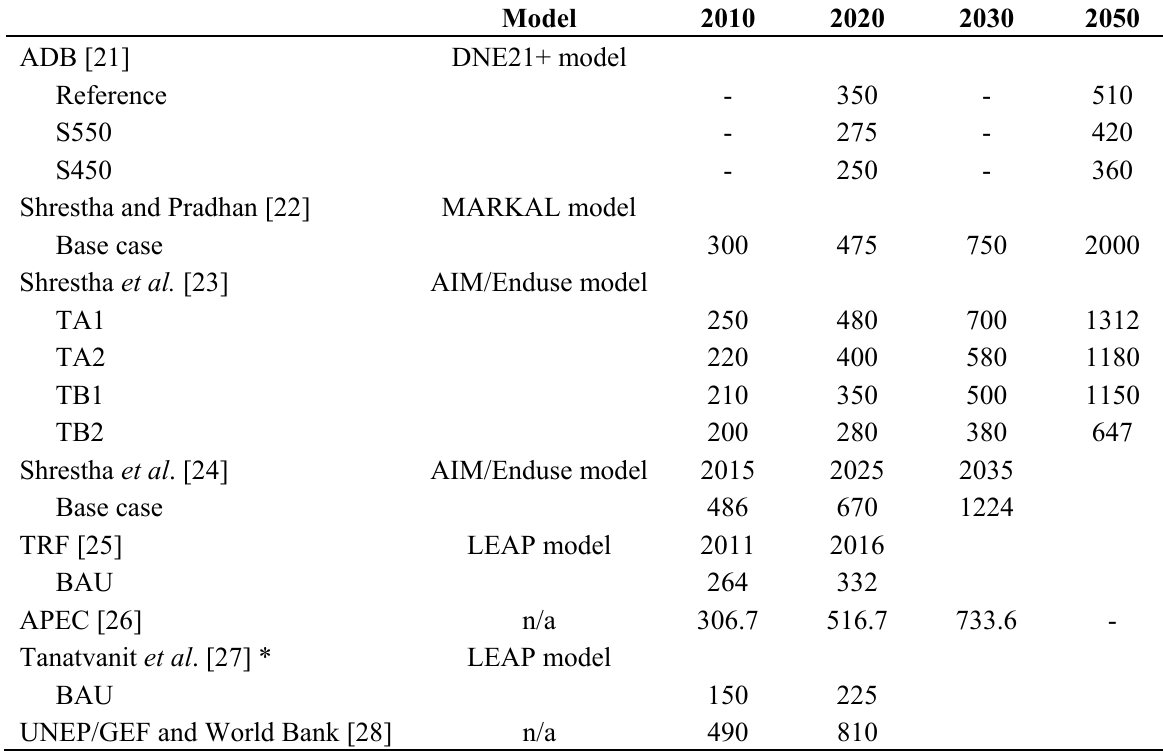
Table 3. Estimation of energy-related CO scenarios (MtCO 2